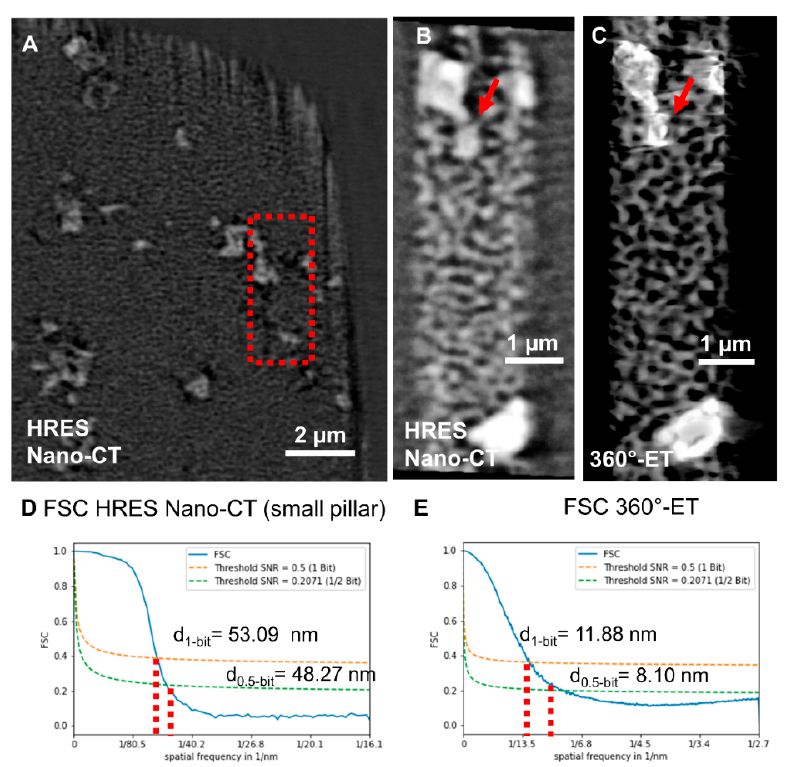
Figure 4. Direct comparison of HRES-PC Nano-CT and 360 ◦ -ET reconstructions (sample routine 2 in Table 1). ( A ) Virtual slice through the HRES Nano-CT reconstruction of a pillar with a diameter of